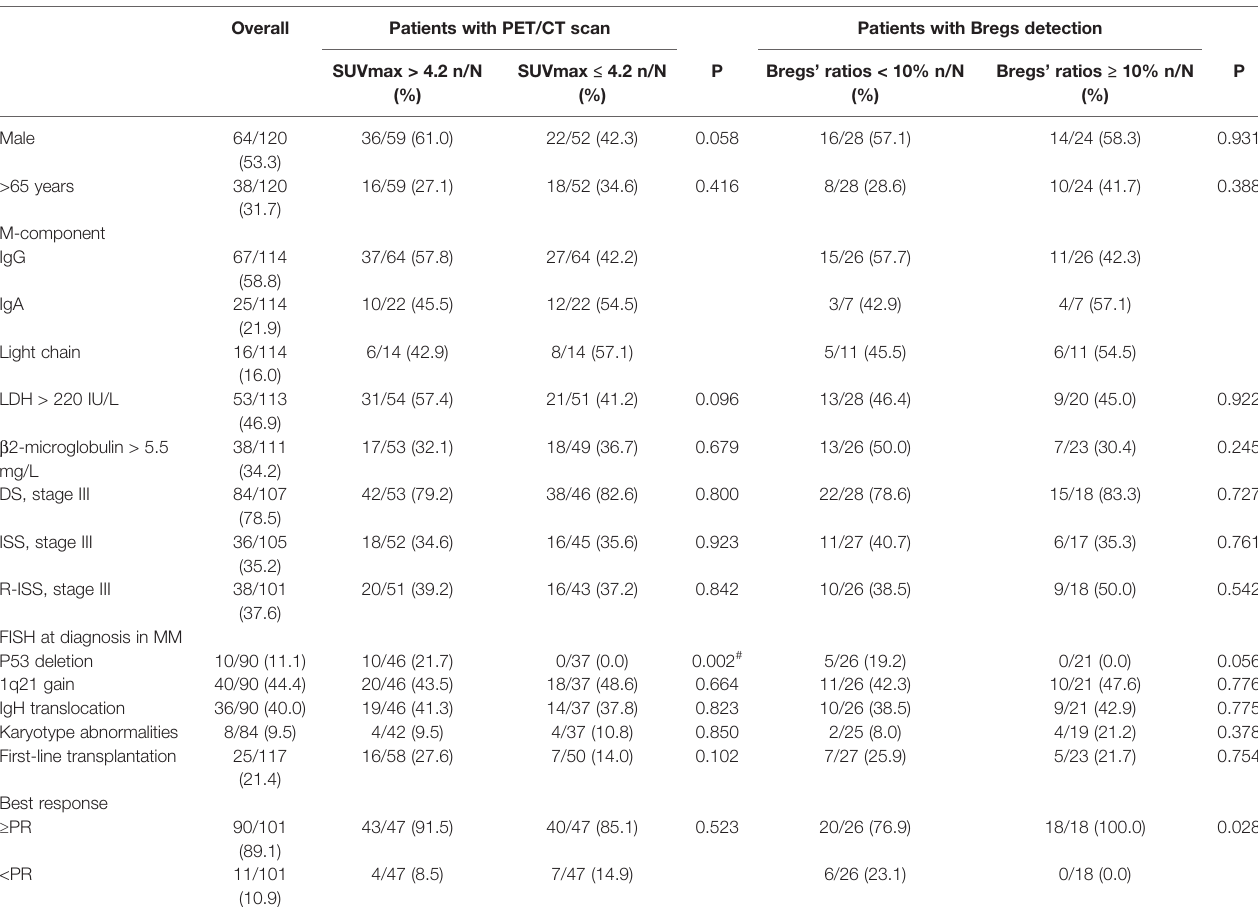
TABLE 1 | NDMM patients ’ demographic and clinical characteristics.